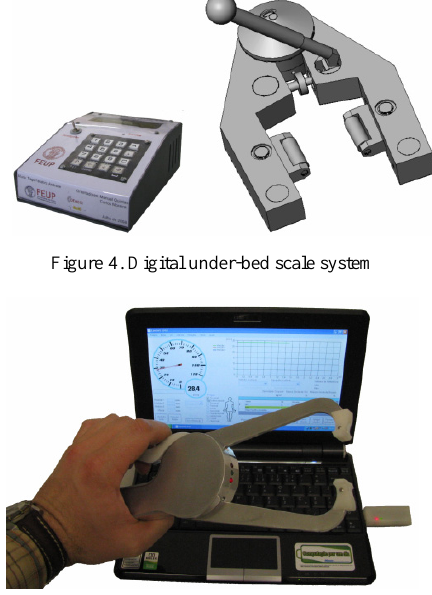
Figure 5. LipoTool – the integrated